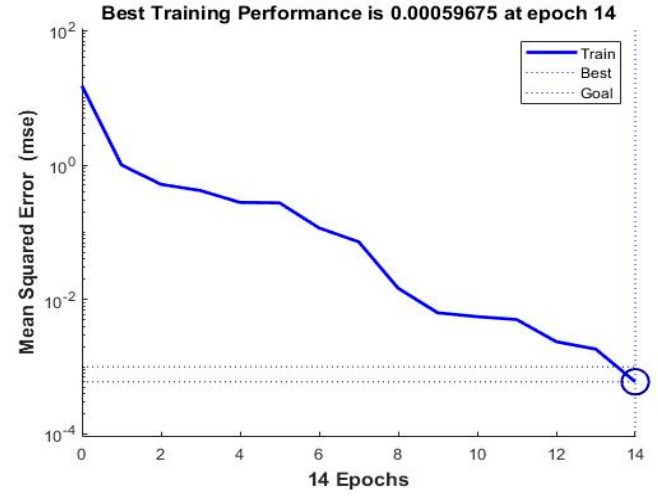
Figure 6. The number of iterations of the BP algorithm.